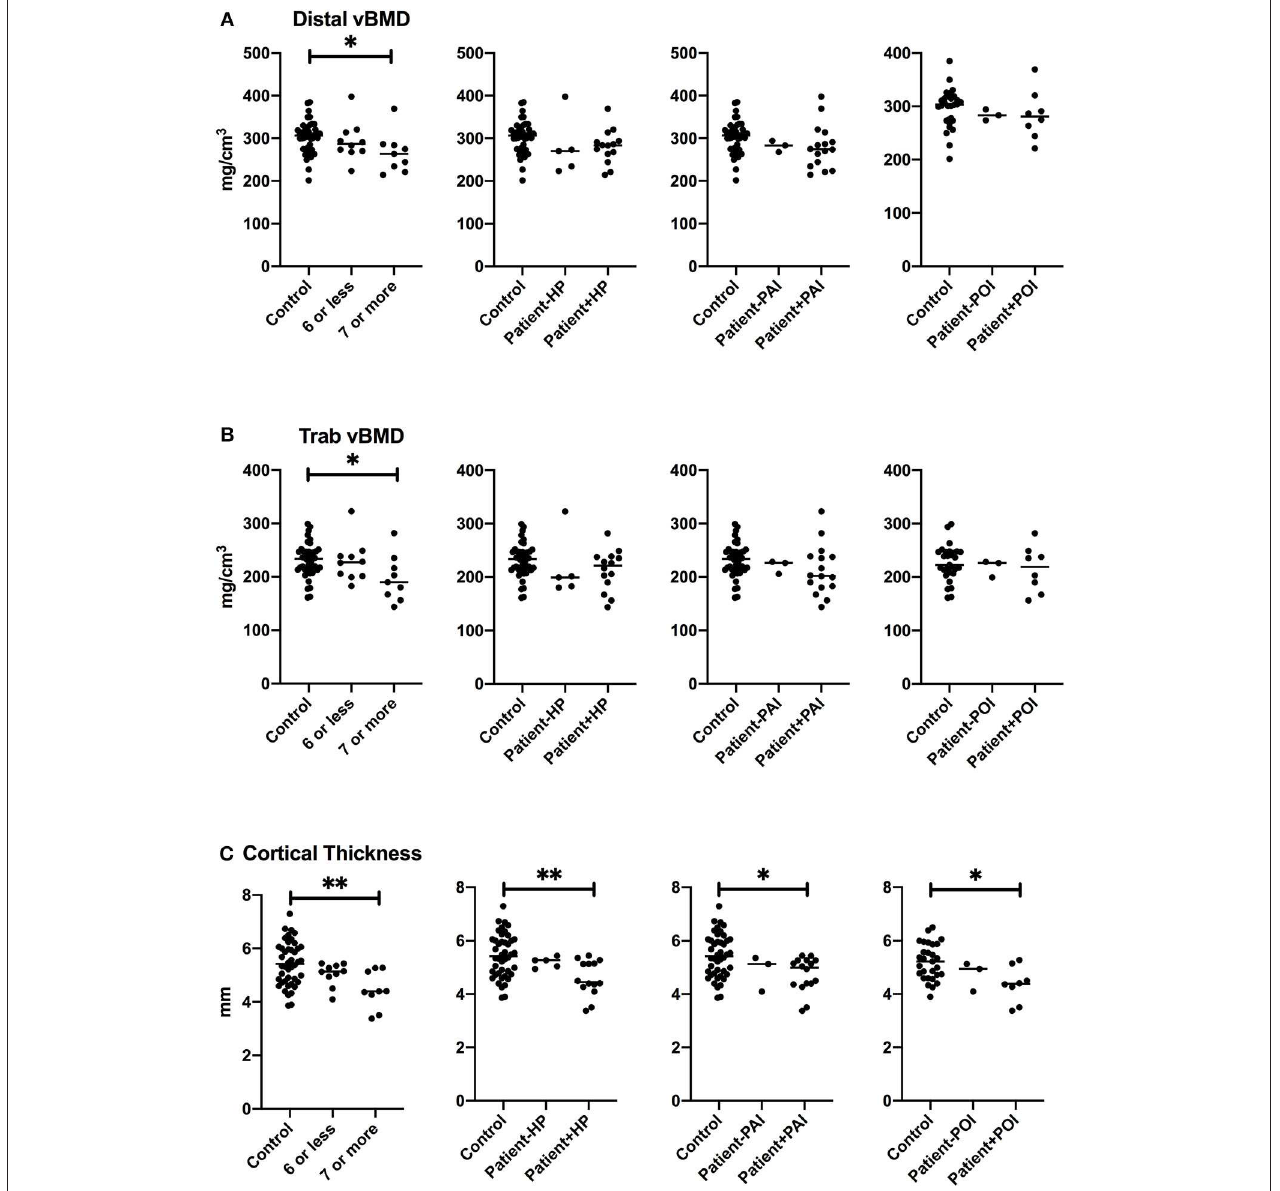
FIGURE 4 | Bone characteristics at tibial site in patients older than 40 years with specific manifestation of APECED. Total volumetric bone mineral density at distal site (A) , trabecular volumetric bone mineral density (B) , and cortical thickness (C) in the patients with ≥ 7 disease manifestations, hypoparathyroidism (HP), primary adrenal insufficiency (PAI), or primary adrenal insufficiency (POI) in comparison to other patients and age- and gender-matched control subjects. P values are indicated with asterisks: *, < 0.05; **, < 0.01.